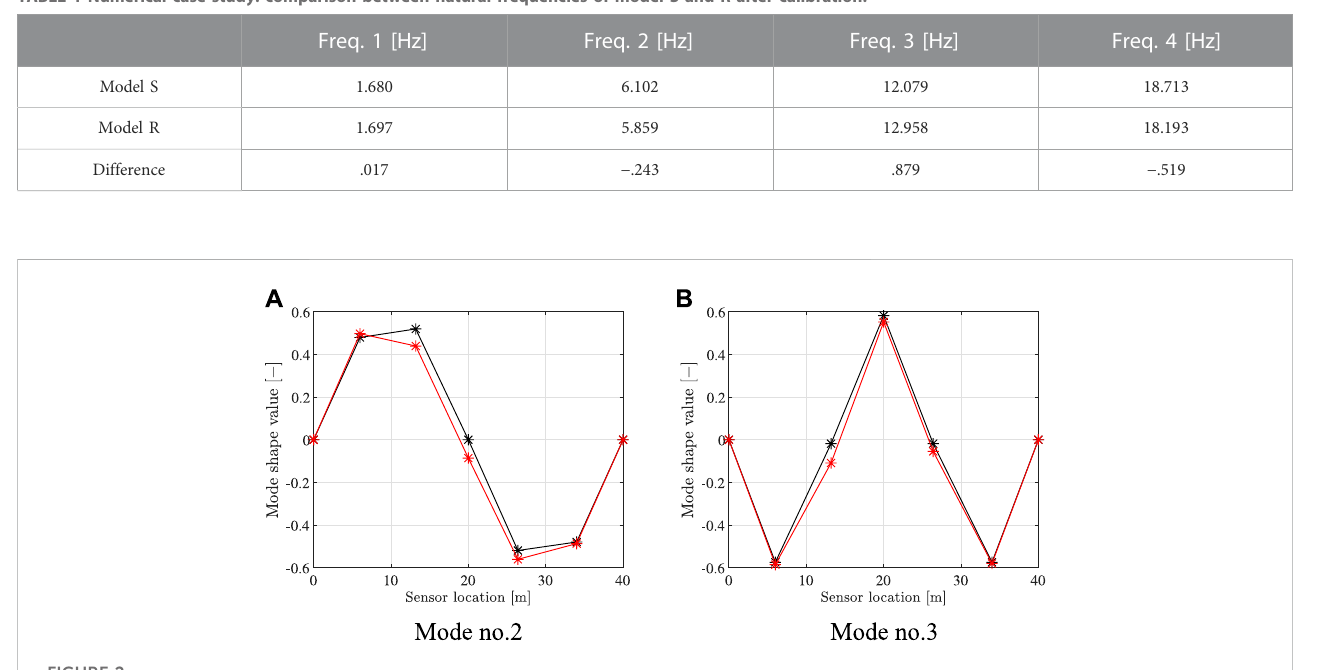
FIGURE 2 Numerical case study: comparison between mode shapes computed by model S (black asterisks) and model R (red asterisks); (A) mode no. 2 and (B) mode no. 3.